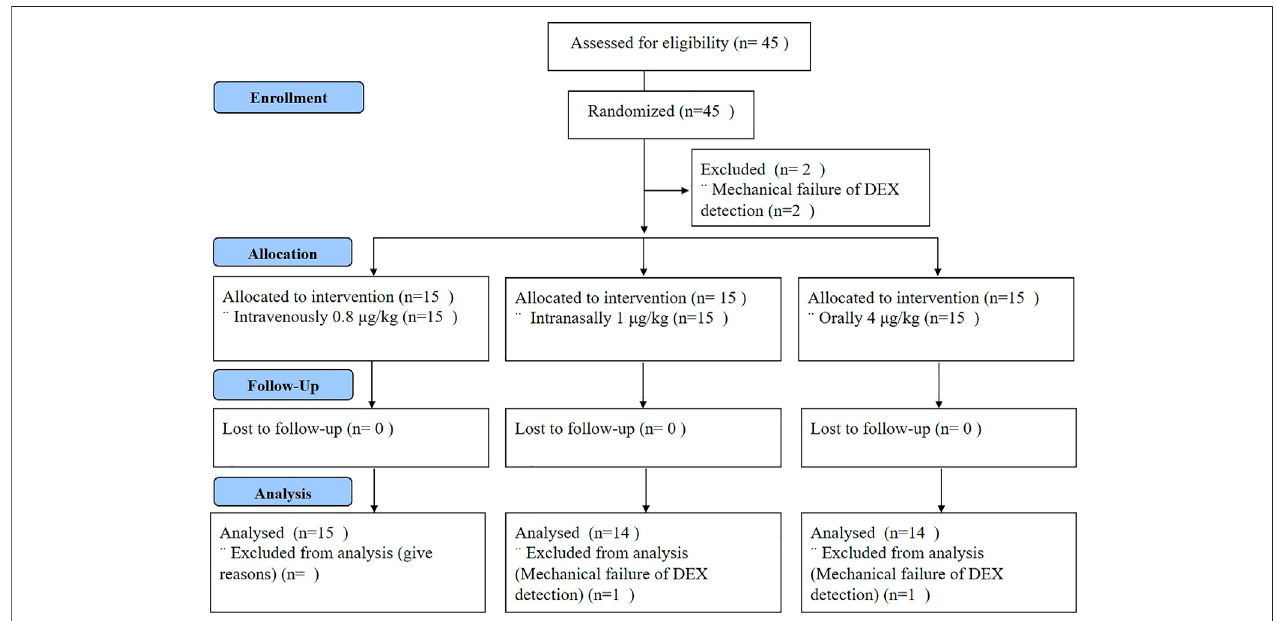
FIGURE1| Study fl owchart.Atotalof45patientswereenrolledinthisstudyandtwopatientswereexcluded.PlasmaconcentrationsofDEXandclinicaldatawere collected for 15 patients in the IV group, 14 in the IN group and 14 in the Oral group. DEX = dexmedetomidine; I.V. = intravenous; I.N. = intranasal.